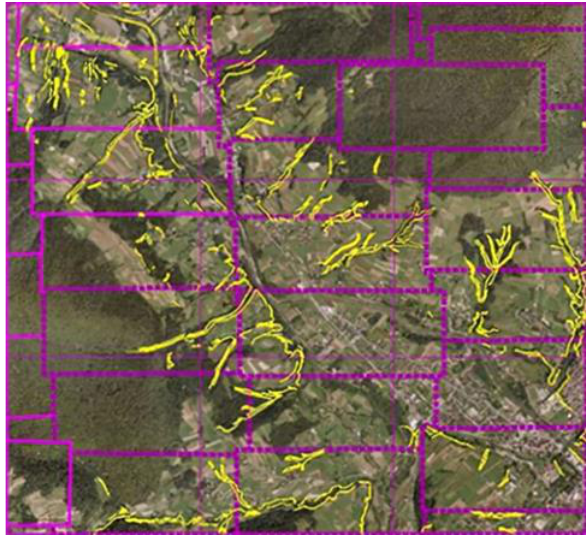
Figure 24. Mosaic created from 33 fragments of aerial photographs, being the basis for creating the texture of the DSM model. The yellow color represents the slopes of the relief model.